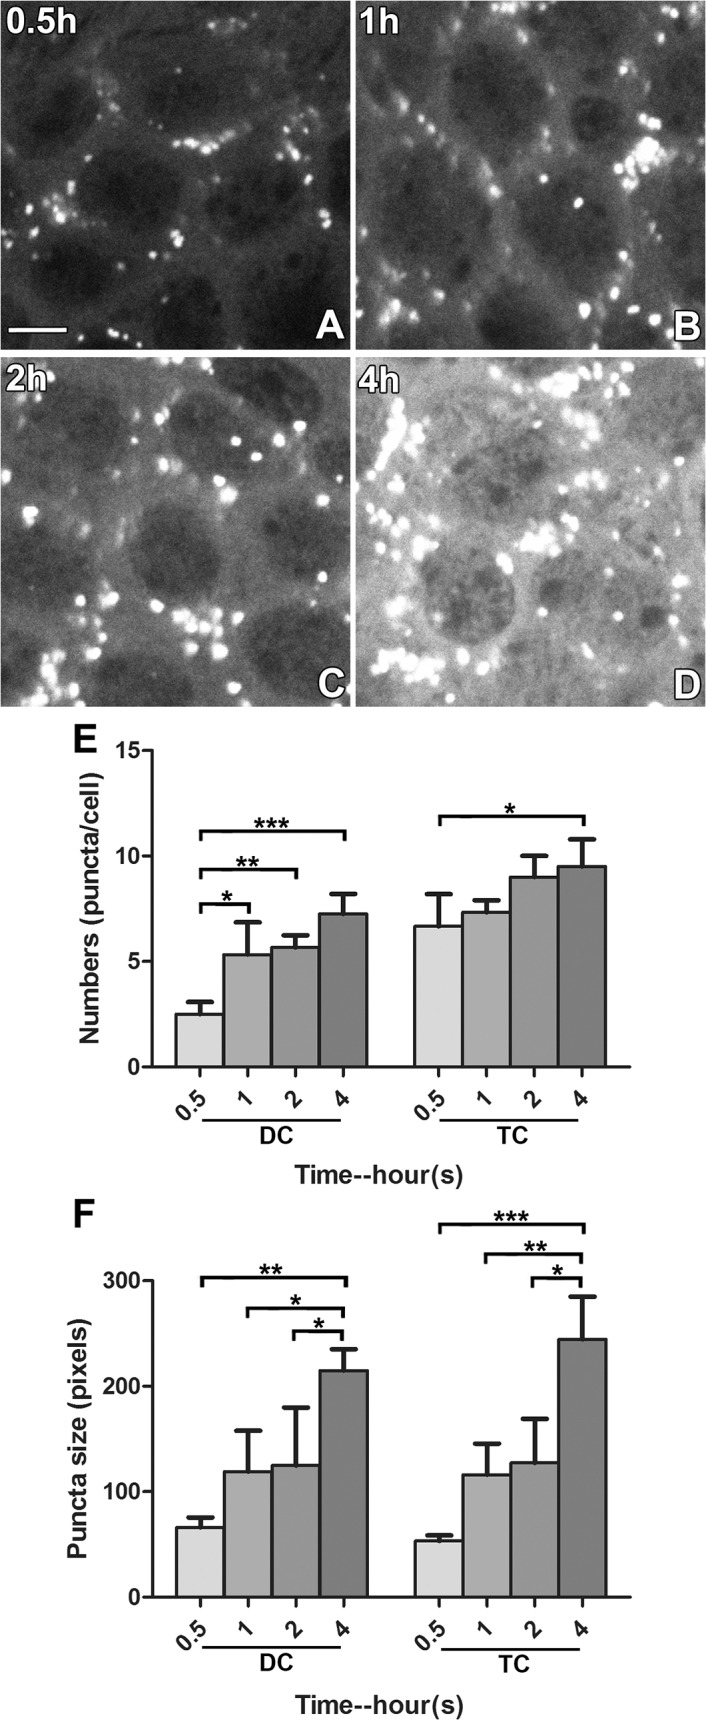
GTTR puncta in dark cells and transitional cells increase in number and size over time.(A-D) Small GTTR puncta were detectable in dark cells at 0.5 hours, becoming visibly larger in size at 1, 2, and 4 hours after injection. Scale bar in A = 20 μm. (E) The number of puncta per cell tended to increase over time in both dark and transitional cells. In dark cells, a significantly higher number of puncta per cell was observed at 1h compared to at 0.5h (p<0.05). In transitional cells, a significantly higher number of puncta was found between 4h and 0.5h (p<0.05; * p<0.05, ** p<0.01, ***p<0.001; mean ± s.d.; n = 5). (F) Both dark and transitional cells displayed a similar trend of increasing puncta size over time. Difference in puncta size at 0.5, 1, 2, and 4 hours was statistically significant (* p<0.05, ** p<0.01; mean ± s.d.; n = 5). Saturated cytosolic GTTR levels of the 3 hour group did not allow individual puncta to be distinguished and were not quantitated.